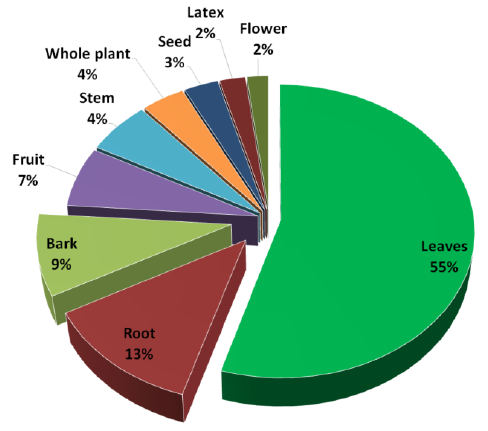
Figure 1. Plant parts used to prepare medicinal remedies.